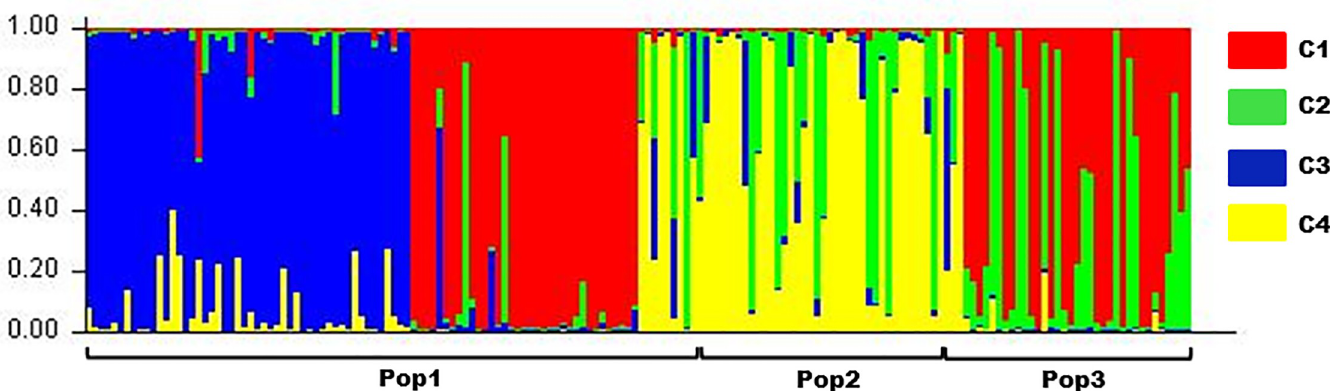
Fig 2. Genetic clustering of horses from all populations (Pop1, Pop2, Pop3) based on the Bayesian model for K = 4. Pop1, Polish draft horses; Pop2, semiferal Konik Polski horses; Pop3, Konik Polski horses, stabled group. The colors apply to different genetic clusters (C1, C2, C3, C4).